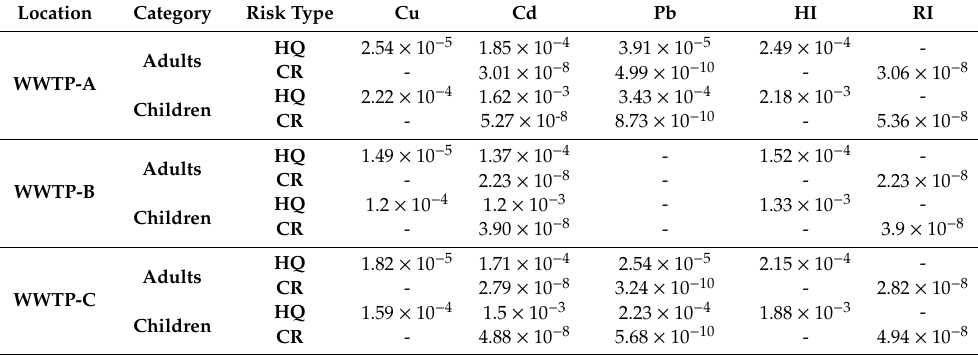
Table 4. Carcinogenic and non-carcinogenic risks assessment by ingestion in sewage sludge.